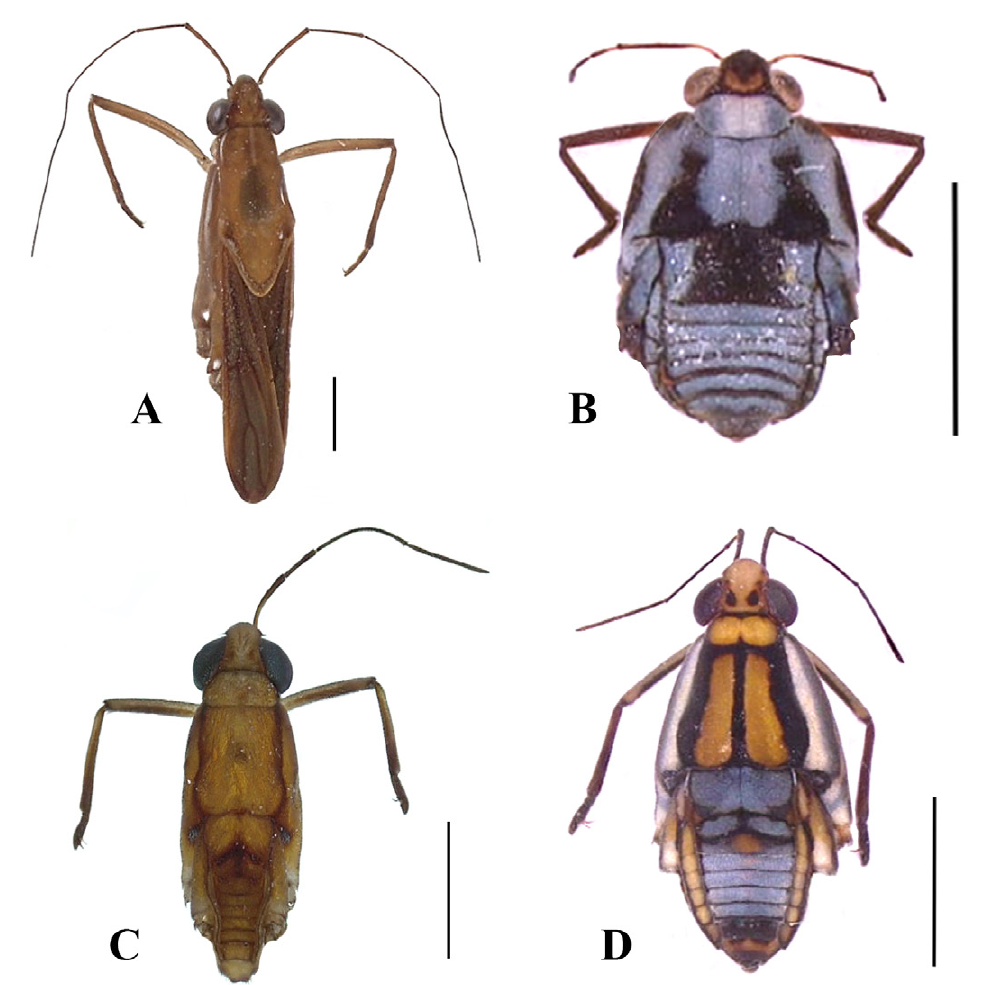
Figure 2. Habitus, dorsal view. A. Tachygerris tucanensis . B. Metrobates amblydonti . C. Telmatometra indentata. D. Telmatometra